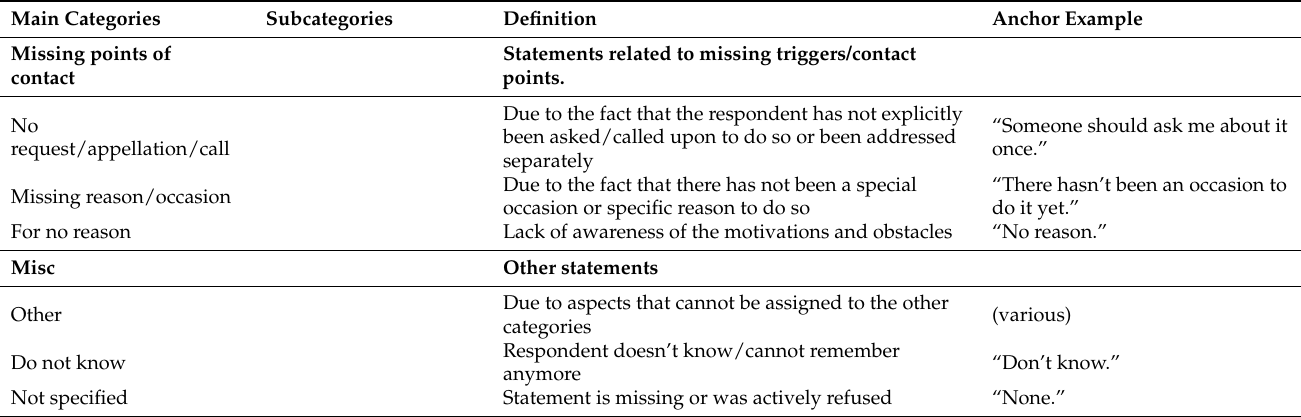
Table 4. ( a ) Self-reported motivators and deterrents for retrospective (lifetime) blood donation behaviour—results